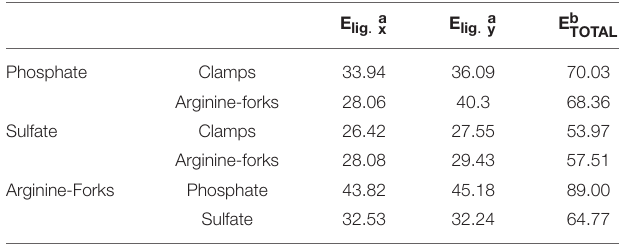
All values are displayed in kcal mol − 1 . a The index x and y corresponds to each bond between oxygen and hydrogen atoms. Please, refer to Figure 6 for clarity. b E TOTAL corresponds to the summation of each column values.